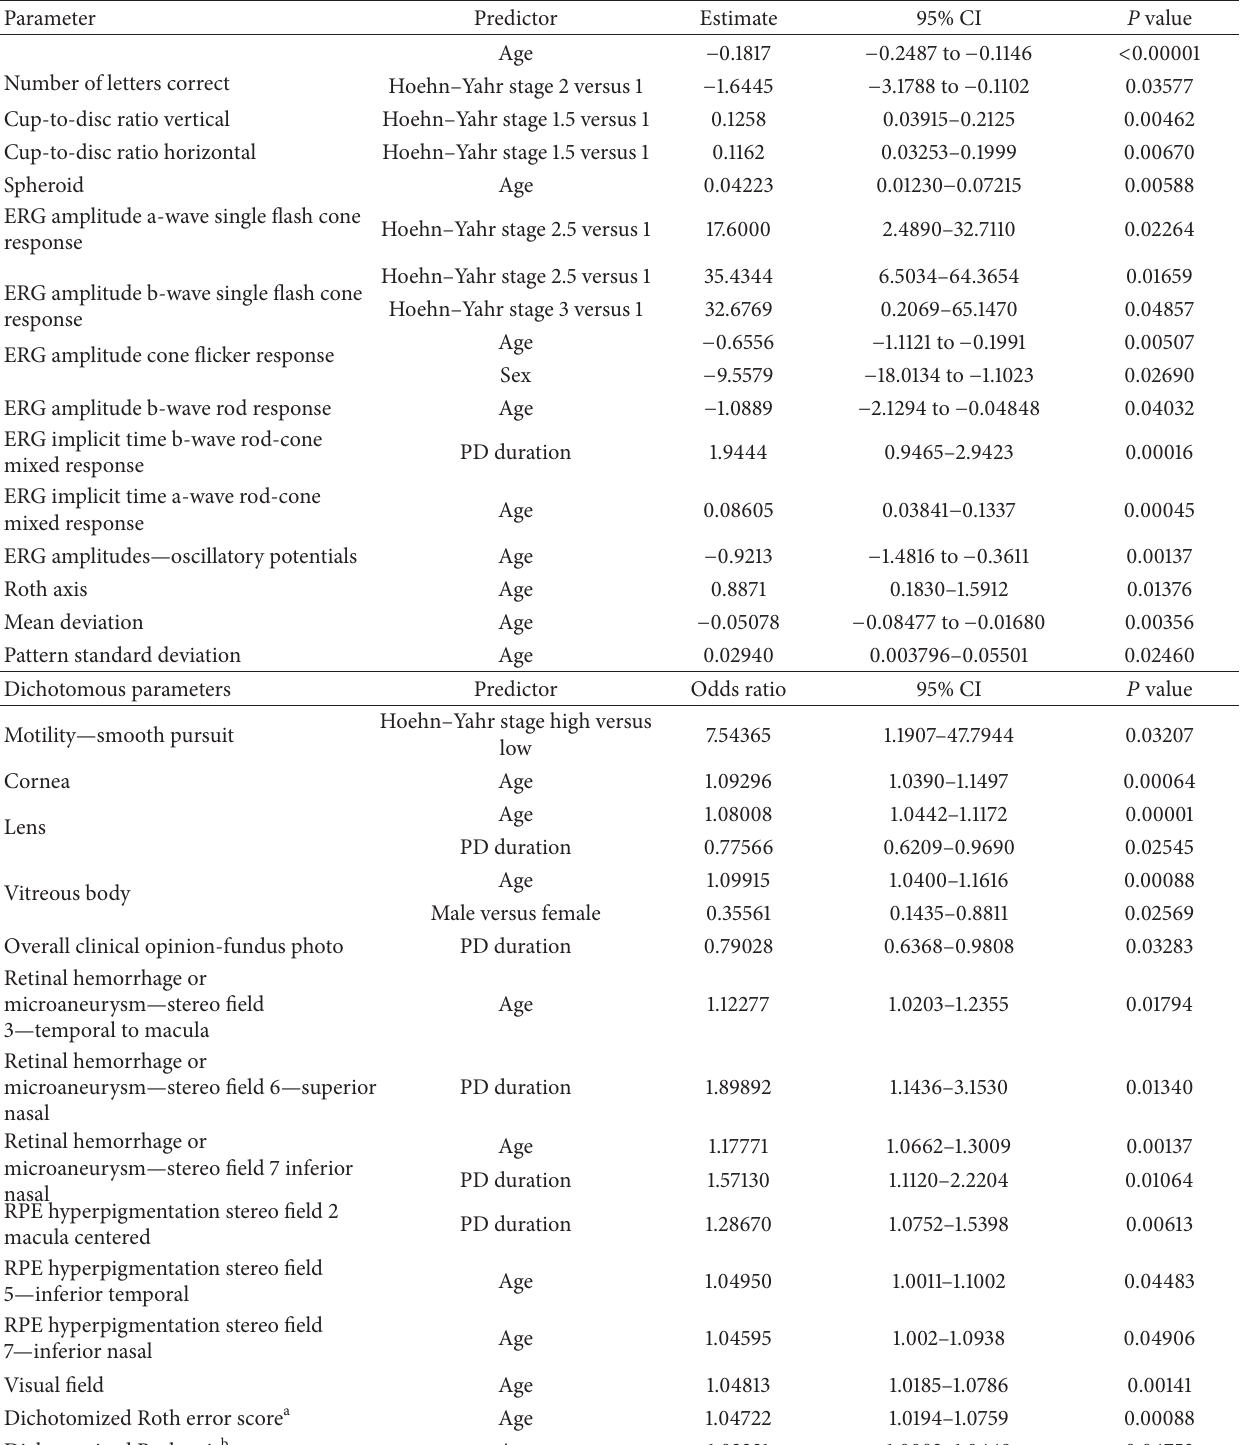
Table 3: Statistically significant multivariate predictors of baseline ophthalmologic outcomes (all-eyes models as described in Statistical